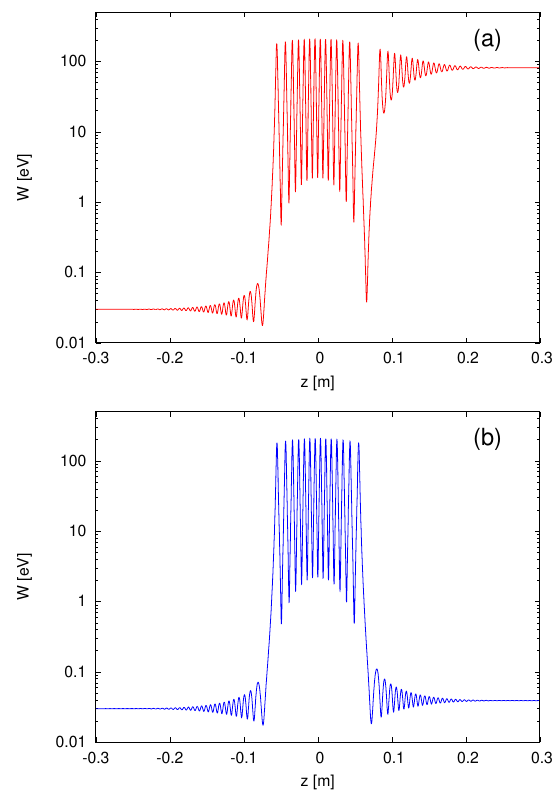
Figure 1. Electron energy W = mc 2 ( γ − 1) versus spatial coor- dinate z , obtained solving the Hamiltonian equations of motion for two di ff erent initial phase values χ , (a) and (b), respectively). The chosen parameters are: EC power P = 1 MW, beam width w = 10 cm, frequency ratio 2 Ω /ω = 1, for second harmonic XM polarisation in oblique propagation with N (cid:107) = 0 .